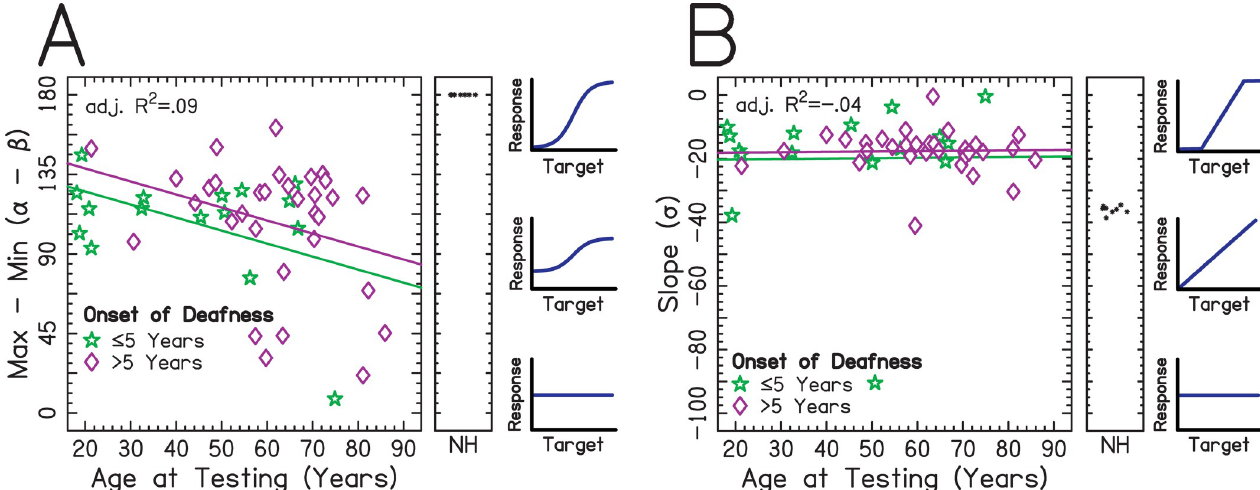
Fig 5. Relationship between logistic parameters and patient-dependent factors. Individuals with an onset of deafness � 5 or > 5 years are shown in green ☆ and magenta ^ symbols, respectively. The x-axis represents age at testing in years. The adjusted R 2 was taken from a regression including factors of onset of deafness group and age at testing. The sub-panel offset to the right shows data from NH listeners. An illustration of the localization function is shown to the right of the sub-panels for aid of interpretation. (A) The y-axis represents the range of response angles ( α – β from Eq 1) of the localization function, where lower values indicate smaller ranges of responses and poorer performance. (B) The y-axis represents the slope ( σ from Eq 1) of the localization function.